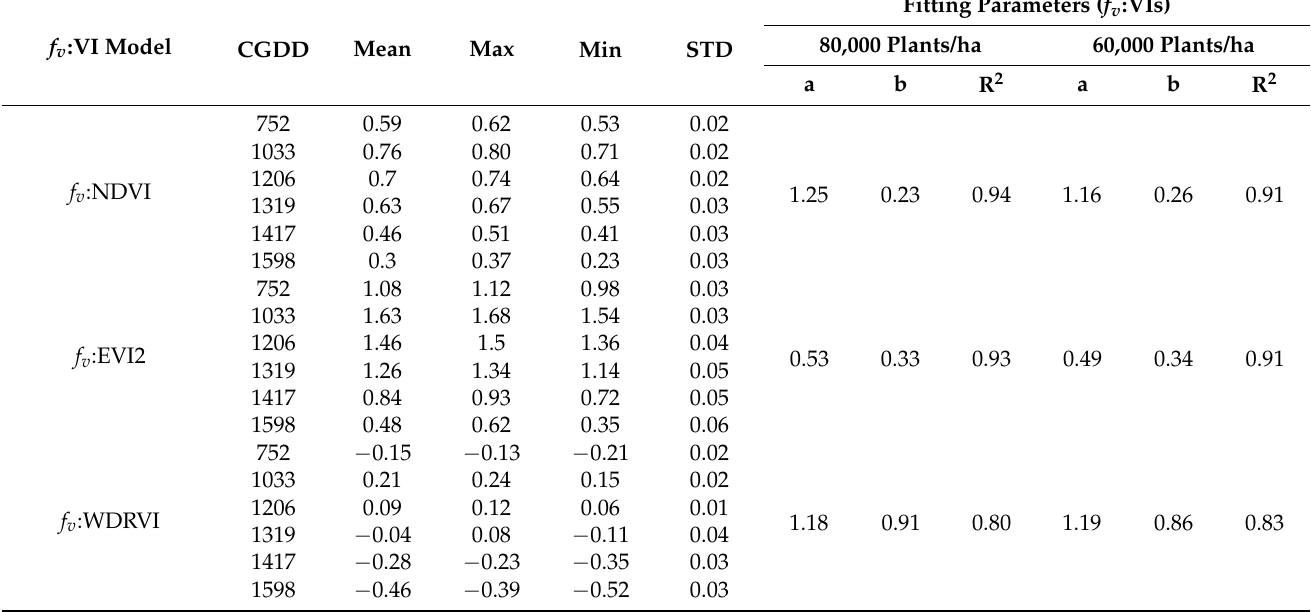
Table 5. Statistical parameters resulting from Kc fv :VIs model fitting using observed Kc-CGDD data.